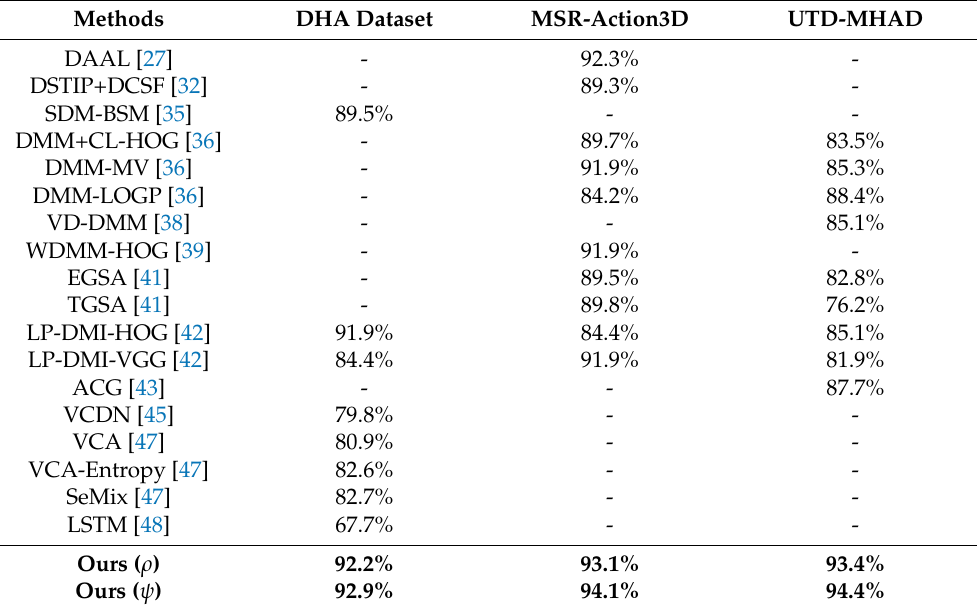
Table 2. Performance comparisons of the DHA, MSR-Action3D, and UTD-MHAD datasets with state-of-the-art